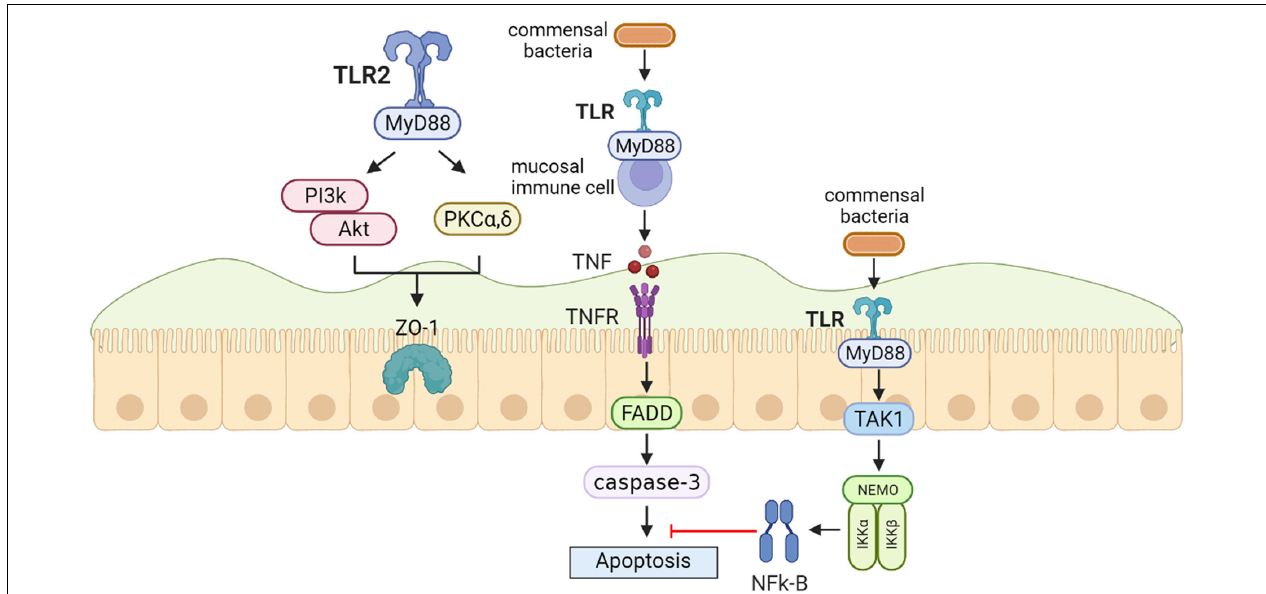
FIGURE 2 | Toll-like receptors (TLRs) protect the intestinal epithelial barrier. In intestinal epithelial cells, TLR2 stimulation efficiently preserves zonula occludens-1 (ZO-1)-associated barrier integrity against stress-induced damage, which is controlled by positive signaling crosstalk between PI3K-Akt and conventional protein kinase C (PKC) isoforms via MyD88. In the steady-state conditio, commensal bacteria induce the production of physiologically optimal concentration of inflammatory cytokines [tumor necrosis factor (TNF)] in mucosal immune cells. Epithelial nuclear factor- κ B (NF κ B) has an important role in the anti-apoptotic function that is mediated by TAK1 and the inhibitor of NF-jB kinase (IKK) complex including NF-jB essential modulator (NEMO), IKKa, and IKKb.